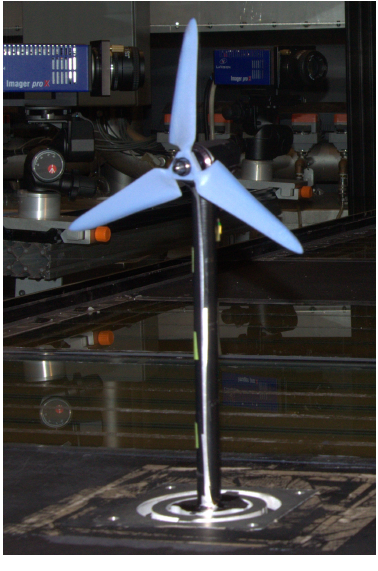
Figure 2. Wind turbine model with gimbal support. The gimbal is blocked for fixed case measurements. Scale 1:400, with D = 0.2 m. Power coefficient c 0.26 for floating case. Tip speed ratio λ ≈ 6. Thrust coefficient c 0.85 for the floating case. Black coverage is to avoid laser beam